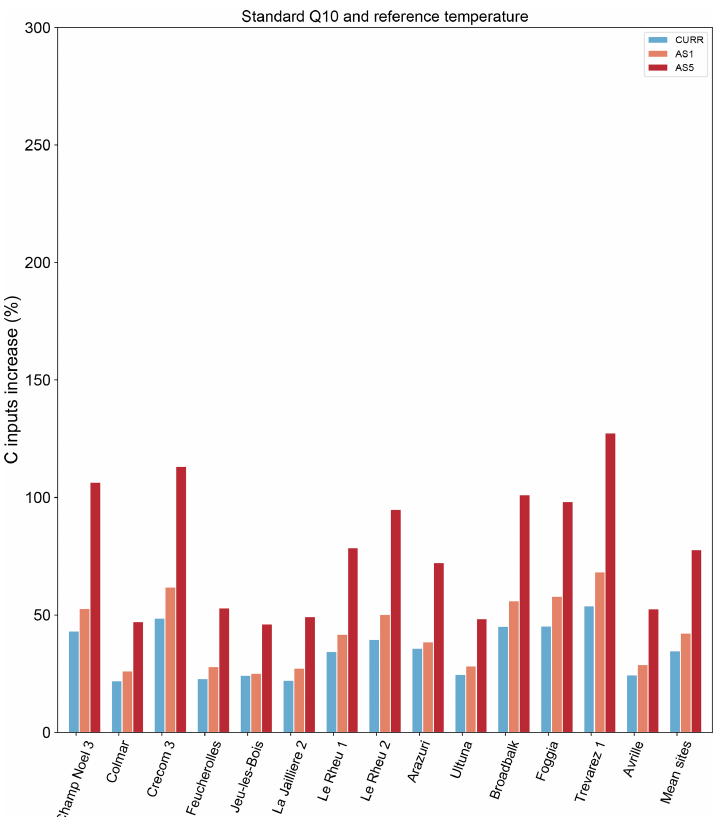
Figure C1. Temperature sensitivity analysis of carbon input change (%) to reach the 4p1000 objective, using Century default Q 10 and reference temperature parameters. CURR: business-as-usual simulation; AS1: RCP2.6 scenario of + 1 ◦ C temperature increase; AS5: RCP8.5 scenario of + 5 ◦ C temperature